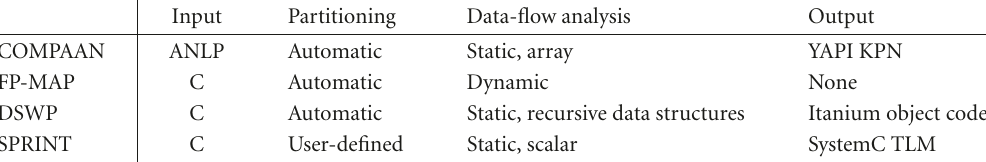
Table 4: A comparison of SPRINT with related